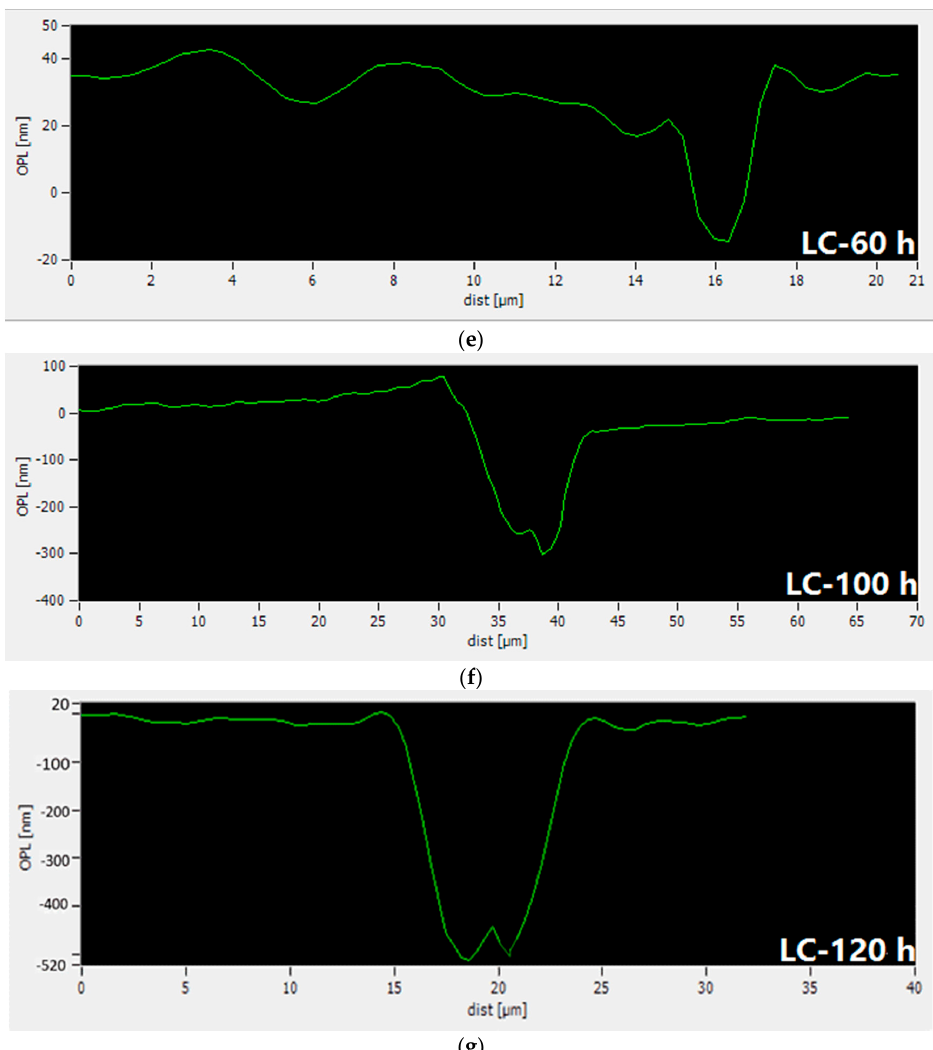
Figure 3. Surface morphology and pitting depth in carbon steel bars at different corrosive exposure times. ( a ) Surface morphology for LC at 0 and 24 h; ( b ) Surface morphology for LC at 60 and 100 h; ( c ) Surface morphology for LC at 120 h; ( d ) Pitting depth for LC at 24 h; ( e ) Pitting depth for LC at 60 h; ( f ) Pitting depth for LC at 100 h; and ( g ) Pitting depth for LC at 120 h. (OPL: Optical path length).